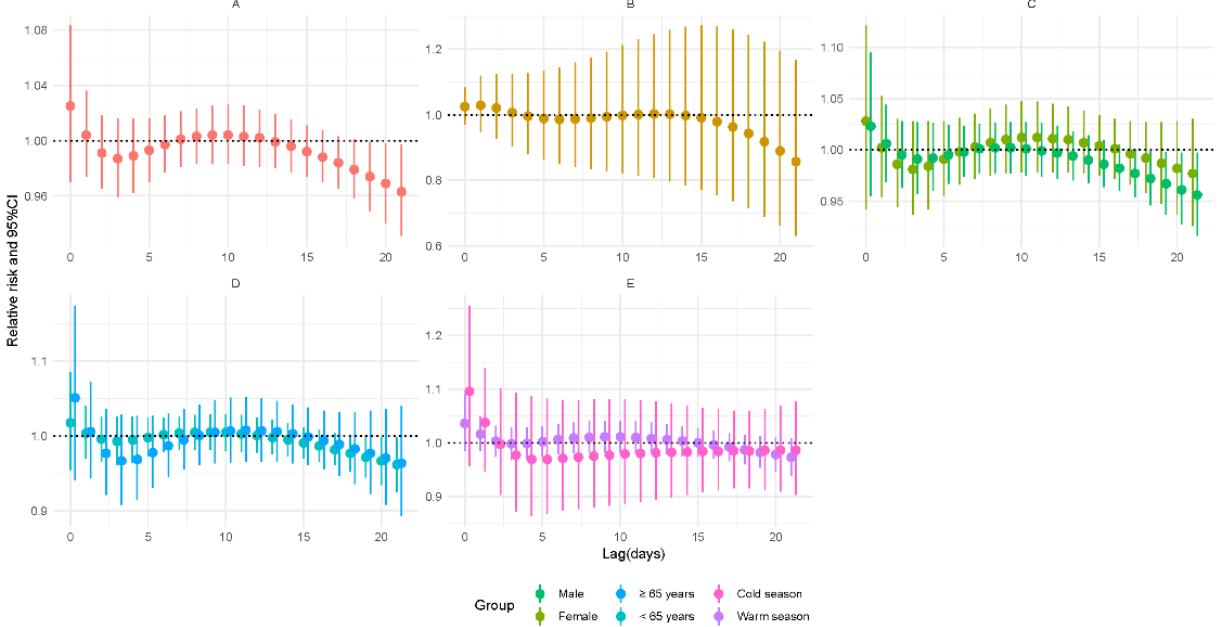
Figure 6. Relative risks for tuberculosis incidence in relation to a 5 µ g/m 3 increase of daily average concentrations of ozone (O 3 ). ( A ) Lag-specific RRs; ( B ) cumulative RRs; ( C ) stratified analysis by gender; ( D ) stratified analysis by age; ( E ) stratified analysis by